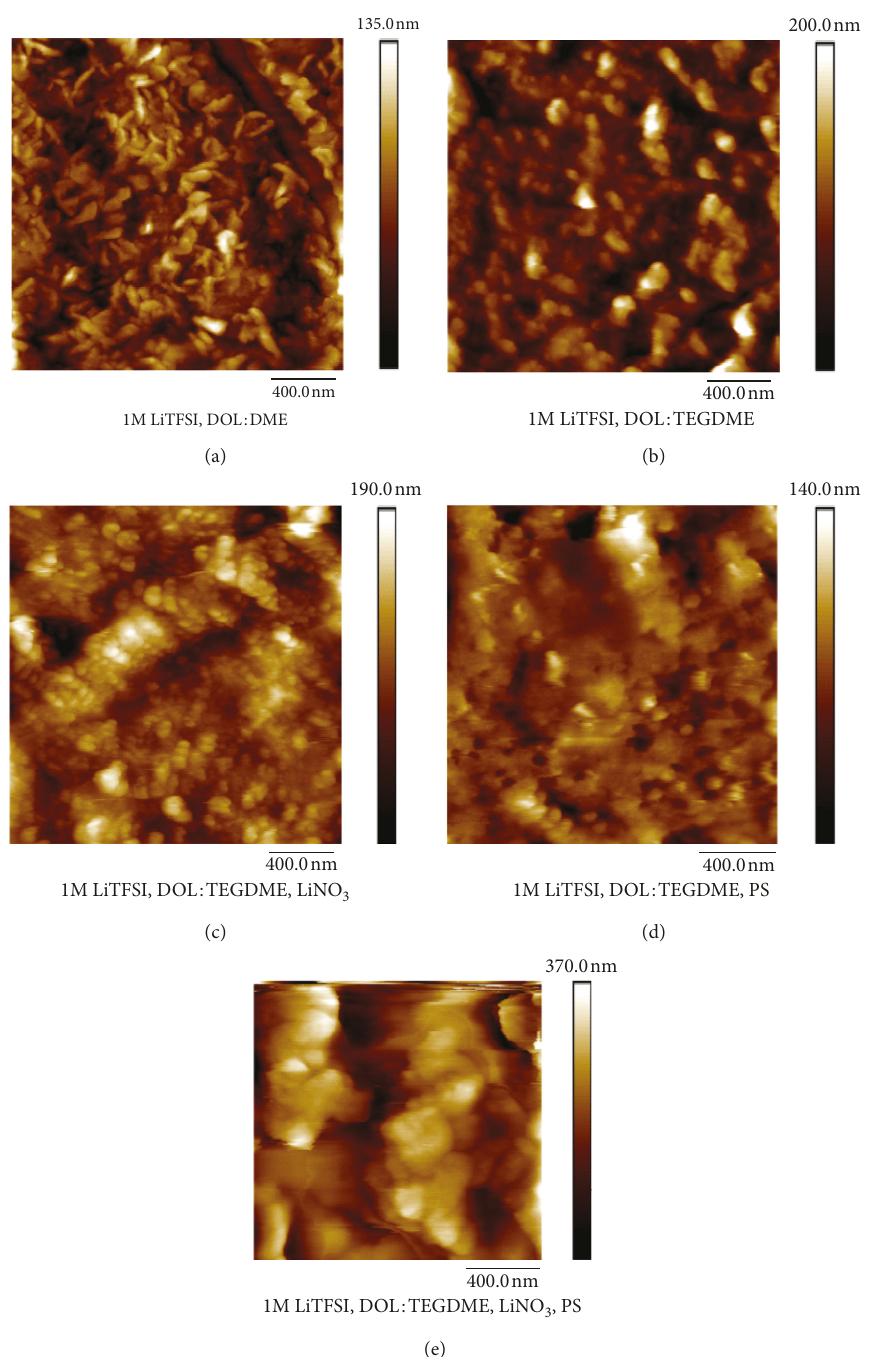
Figure 7: Surface morphology of Li plates after symmetric Li-Li electrochemical cycling in 1M LiTFSI, DOL :DME (7: 3 vol.) (a), 1 M LiTFSI, DOL :TEGDME (b), 1M LiTFSI, DOL :TEGDME, LiNO 3 (c), 1 M LiTFSI, DOL : TEGDME, PS (d), and 1 M LiTFSI, DOL : TEGDME, LiNO 3 , PS